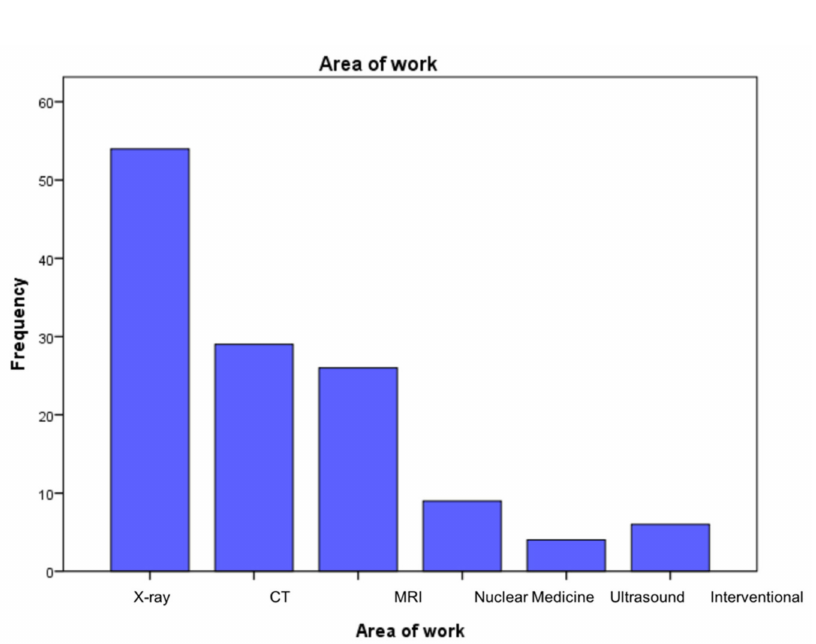
Figure 1. The distribution of participants according to the place of work. Of the total respondents, 98.4% stated that they had received formal training in hand hygiene in the past three years. Only 40.6% of participants knew that respiratory droplets are the primary mode of transmission of the virus from person to person. When participants were asked about the indicators for a patient who reported illness with symptoms ranging from mild to severe, 120 (93.8%) of the participants knew the main indicators, which include being in close contact or residing with an infected person or having travelled to